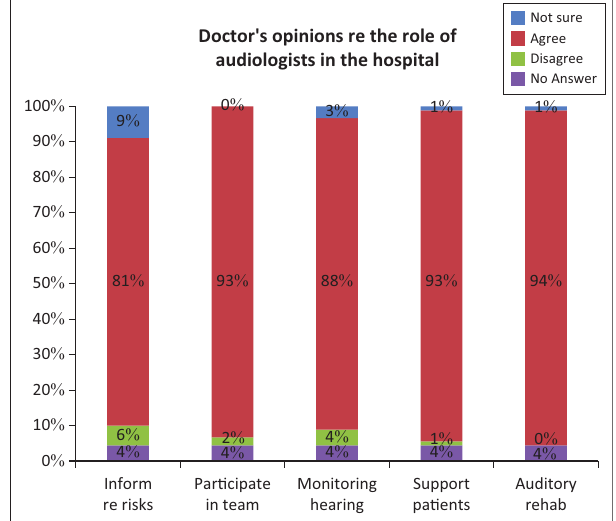
FIGURE 8: Participants’ perceptions of the role of the audiologist in the